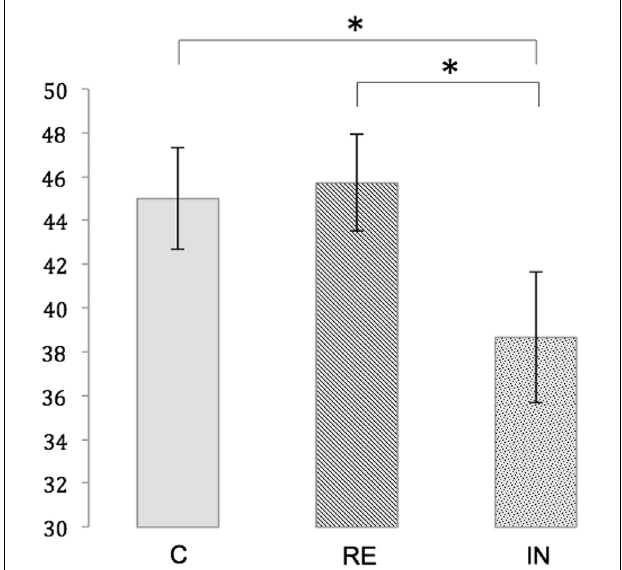
FIGURE 3 | Memory performance for the conditions C (control), RE (reminder) and IN (interference). Depicted is the mean number of correct responses with standard errors. Significant differences at p < 0.05 are marked with an